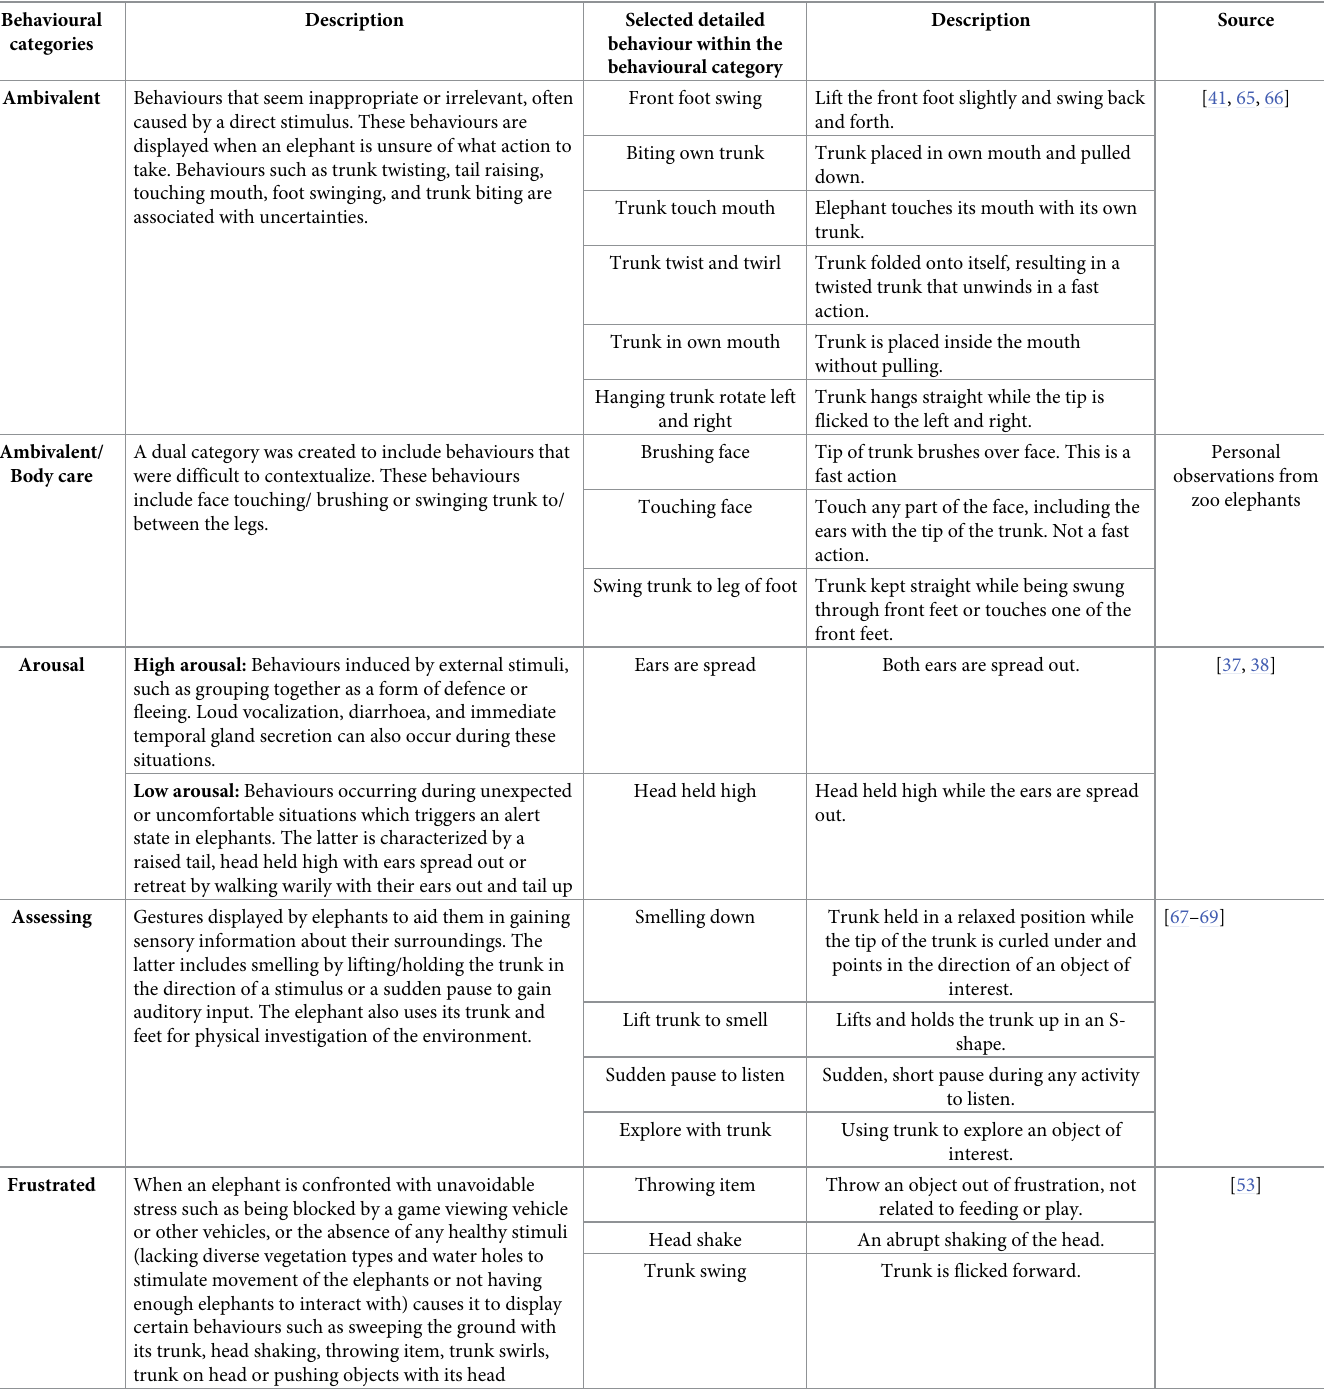
Table 4. Description of the behavioural categories, into which the selected detailed behaviours were categorized. Behavioural